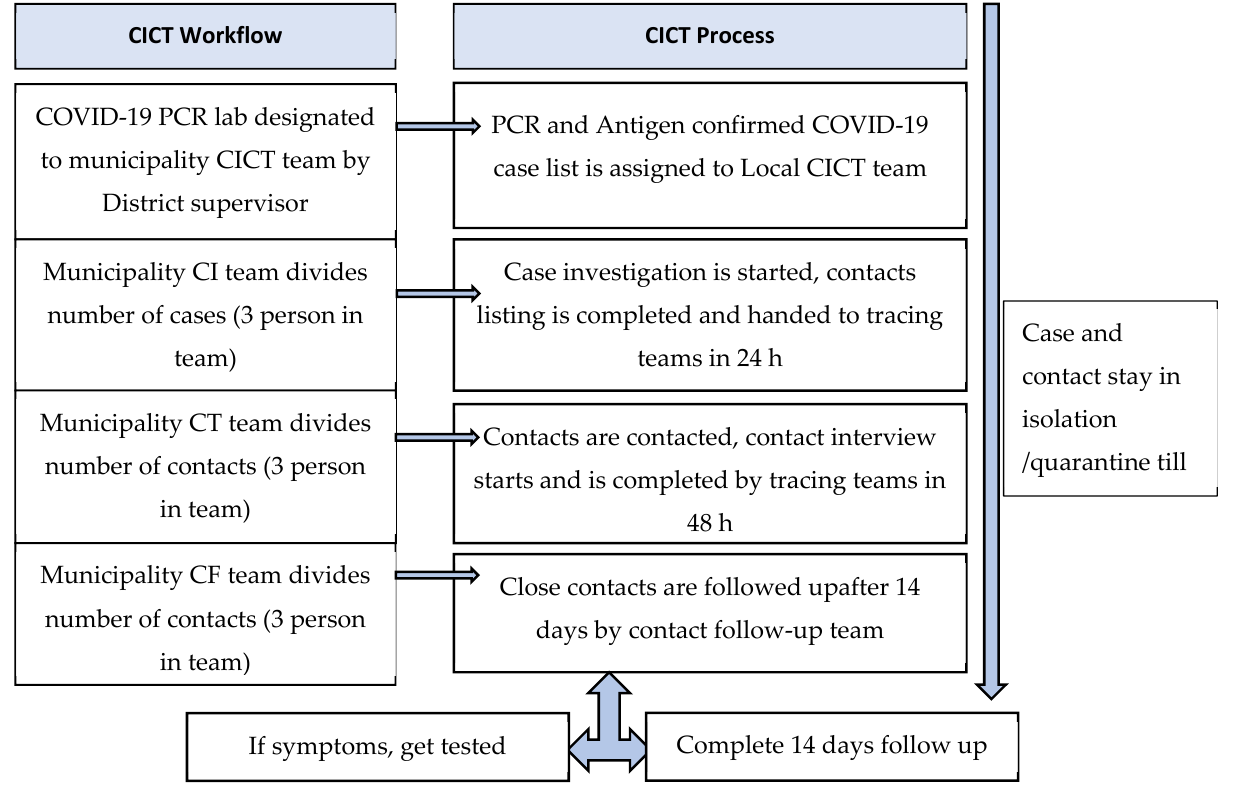
Figure 1. Work process of CICT system in Nepal.